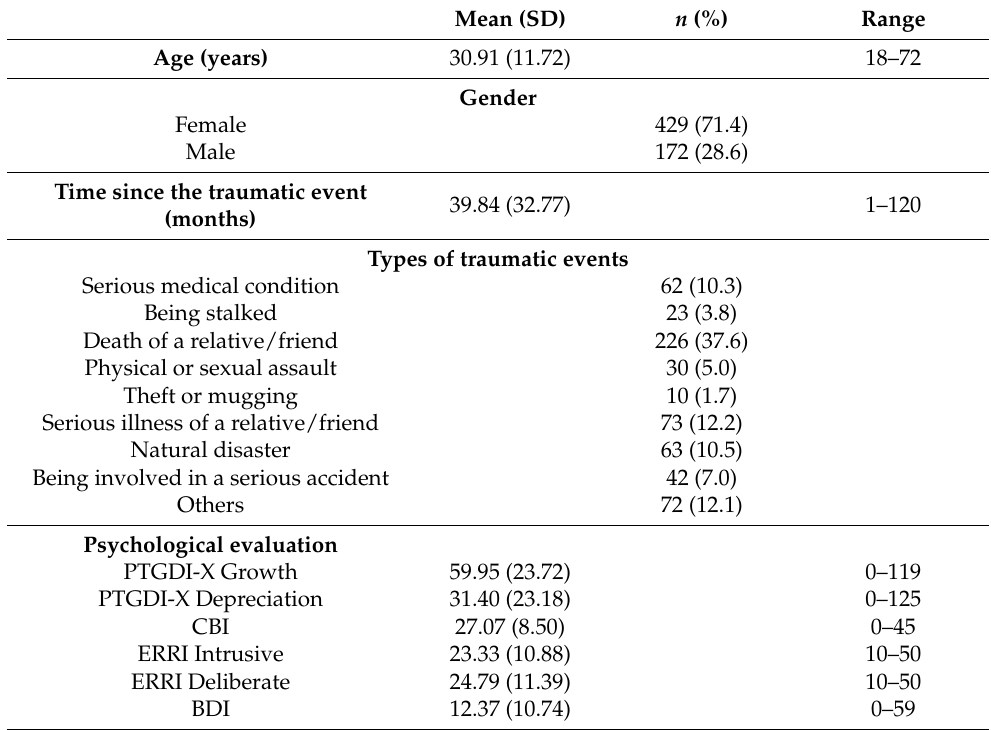
Table 1. Sociodemographic information, trauma-related characteristics, and psychological data of the total sample ( n =